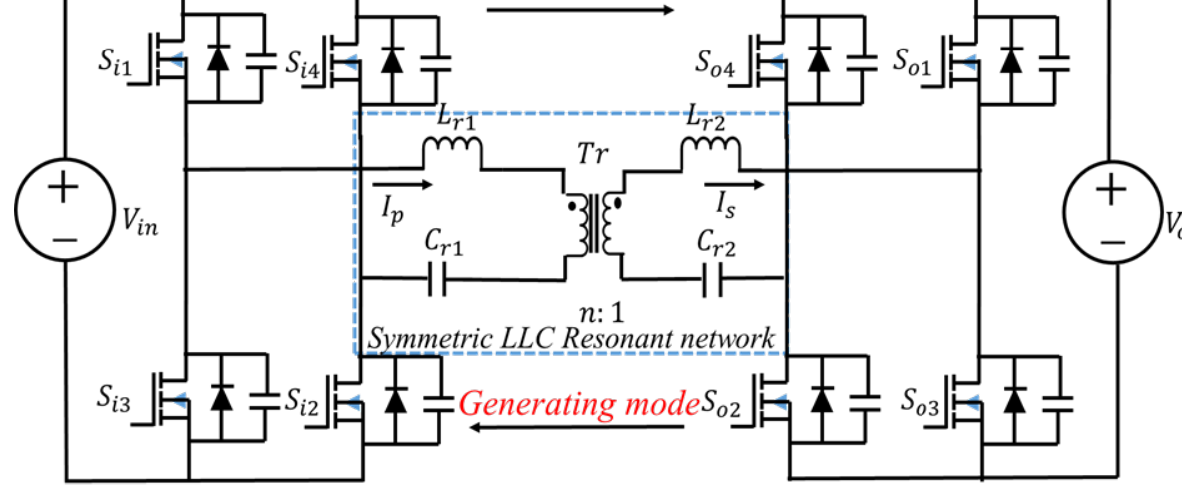
Figure 2. SRC DC-DC converter topology.